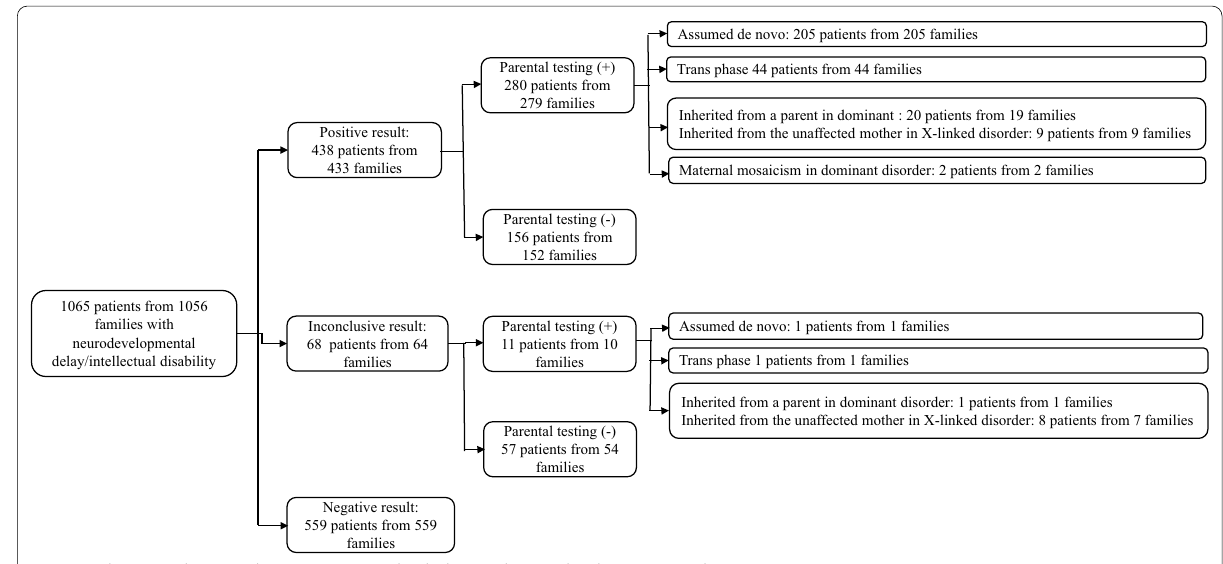
Summary of reanalyzed results and description of patients